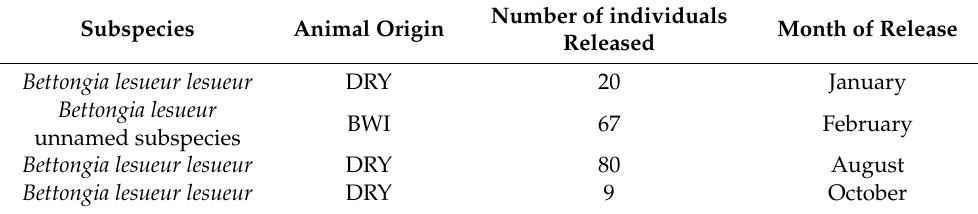
Table 1. Translocation history and the release of the founding individuals for Bettongia lesueur at Matuwa. Subspecies include Shark Bay subspecies ( Bettongia lesueur lesueur ) and Barrow Island subspecies ( Bettongia lesueur unnamed subspecies). Animal origin includes individuals from Dryandra (DRY) and Barrow Island (BWI).